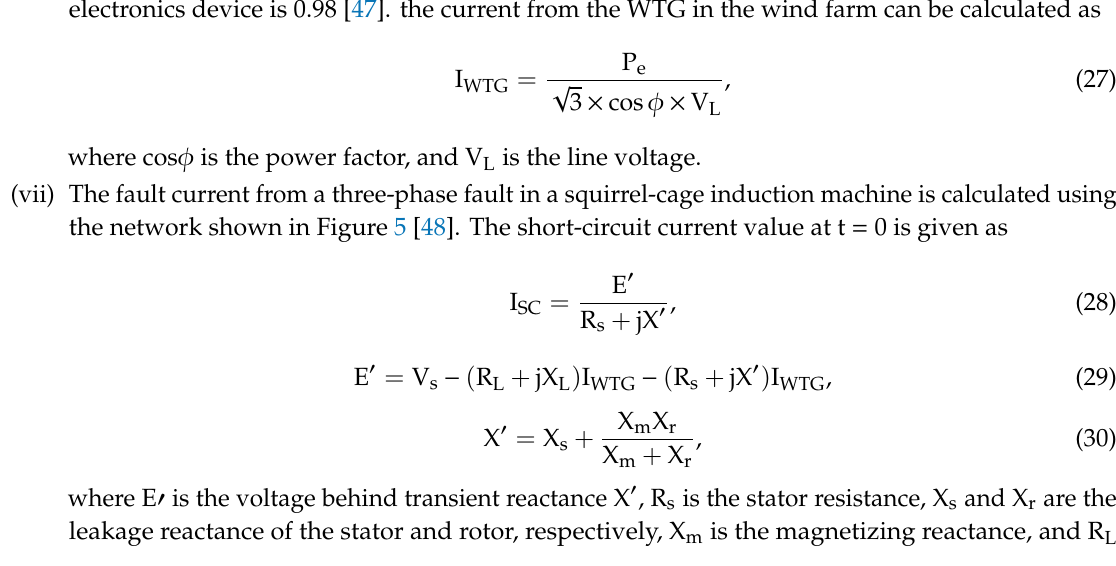
Figure 5. Sequence network circuit for three-phase fault. 3.5. Hybrid HHO–LP Optimization Algorithm